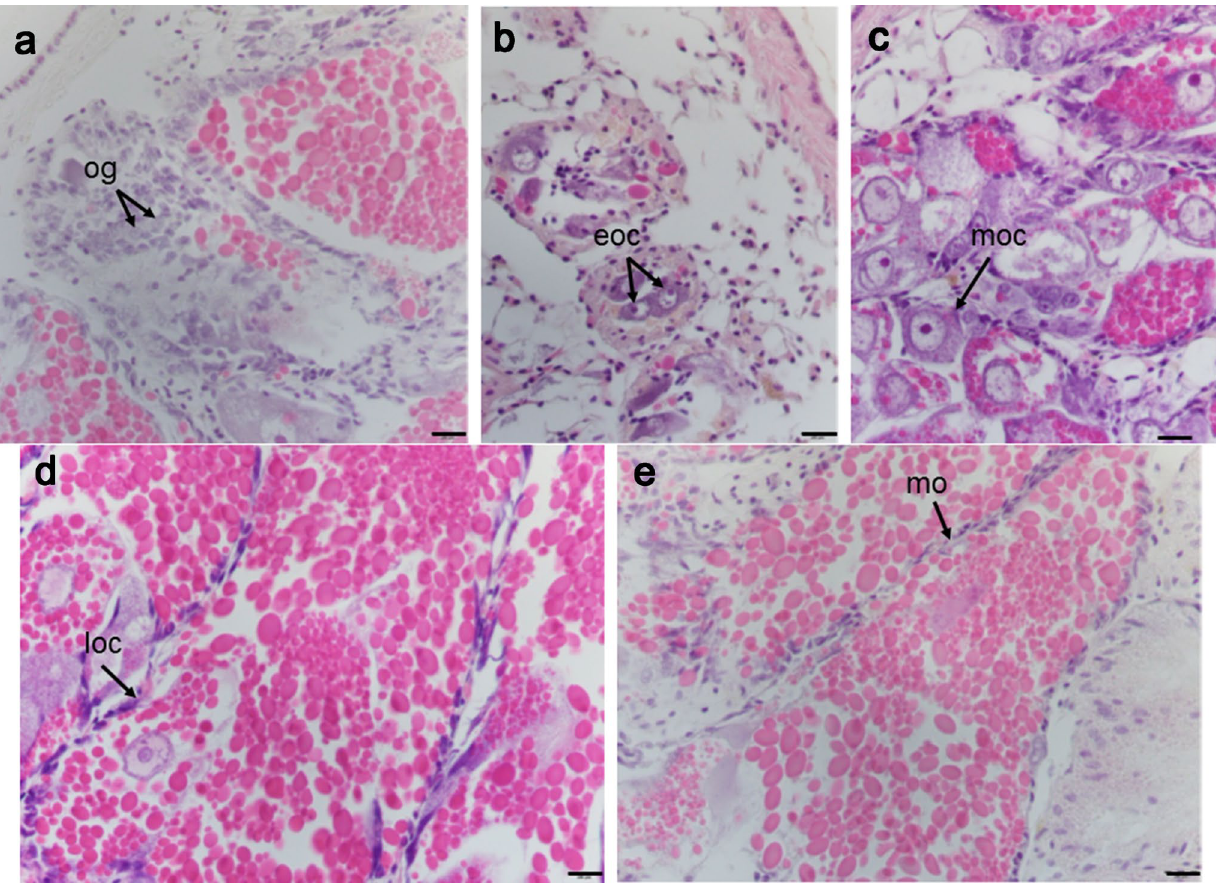
Figure 5. Reproductive cells in ovaries of Thais clavigera : ( a ) oogonium (og), ( b ) early stage oocyte (eoc), ( c ) middle stage oocyte (moc), ( d ) late stage oocyte (loc), and ( e ) mature oocyte (mo). Bars = 200 Histopathological examination of T. clavigera and T. bronni gonads. The gonads of the rock shell specimens collected monthly at each site were fixed in Bouin’s fluid (saturated picric acid : formaldehyde solu- tion : acetic acid = 15 : 5 : 1, all reagents were guaranteed to be extra pure by Nacalai Tesque, Inc.) for 48 h, embedded in paraffin (Sigma-Aldrich, Paraplast Plus), cut into 5–6 μm sections with a rotary microtome (Leica, RM2125RT), and stained with hematoxylin (Tissue-Tek Hematoxylin 3G) and eosin (Tissue-Tek Eosin) by an autostaining machine (Leica, Autostainer XL). Histopathological examination of the gonads was conducted under a light microscope (Olympus, BX40) equipped with a digital camera (Olympus, DP22), and the images were analyzed by using image analysis software (Olympus, cellSens Standard V2.2 (Build 17,989) (https ://www. olymp us-lifes cienc e.com/en/softw are/cells ens/#!cms[focus ]=cmsCo ntent 6017)) installed on a personal com- puter (Hewlett-Packard, DP2-PC-S-1–21). To quantitatively evaluate gonadal maturation in the rock shell specimens, female and male reproductive cells were scored according to a developmental grading system similar to that described by Takamaru and Fuji 61 . Female reproductive cells were categorized according to their degree of maturity as an (1) oogonium or an (2) early (eoc), (3) middle (moc), (4) late (loc), or (5) mature (mo) oocyte (Fig. 5). An oogonium has a nucleus con- taining chromatin chains and a small nucleolus, as well as small, hematoxylin-stained granules. The cytoplasm is thin and its stainability is weak (Fig. 5a). An early stage oocyte is surrounded by a single layer of follicular cells. The large nucleus contains dispersed or scattered chromatin and a large basophilic nucleolus. The early stage oocyte is larger than an oogonium, and it has an irregular shape (Fig. 5b). No yolk globule accumulation is observed in either the oogonium or the early stage oocyte. In the middle stage, the oocyte starts to accumulate eosinophilic yolk granules in the cytoplasm. Its nucleolus is large and basophilic, and chromatin is dispersed in the nucleus. The middle stage oocyte is larger than an early stage oocyte and contains a few yolk globules stained by eosin (Fig. 5c). The late stage oocyte accumulates more eosinophilic yolk globules in the cytoplasm. Its outline is becoming unclear, and its nucleolus is more weakly stained. The late stage oocyte is larger than the middle stage oocyte and contains several yolk globules stained by eosin (Fig. 5d). A mature oocyte has an unclear outline, and its cytoplasm is filled with yolk globules. Its nucleus has an indeterminate form, and the nuclear membrane has disappeared. Small yolk granules cluster around the nucleus (Fig. 5e). The developmental grade of an ovary could range from I to V and was determined on the basis of the char- acteristics of the ovarian tissue and the primary cells observed in the ovary (Table 1). Then, a maturation score